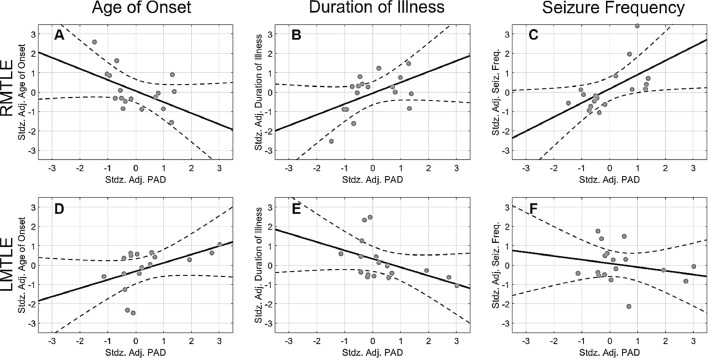
Association between clinical variables and predicted age difference (PAD) in patients with right or left mesial temporal lobe epilepsy. The solid dots, solid lines, and dashed curves in each plot indicate the observation, mean response, and 95% confidence interval of functions, respectively. In left MTLE a data point in the variable of “Age of Onset” exceeded 2.5 times the standard deviation, and was excluded from the correlation analysis. Horizontal and vertical axes denote standardized adjusted (denoted as “stdz. adj.”) PAD scores and clinical factors, respectively.